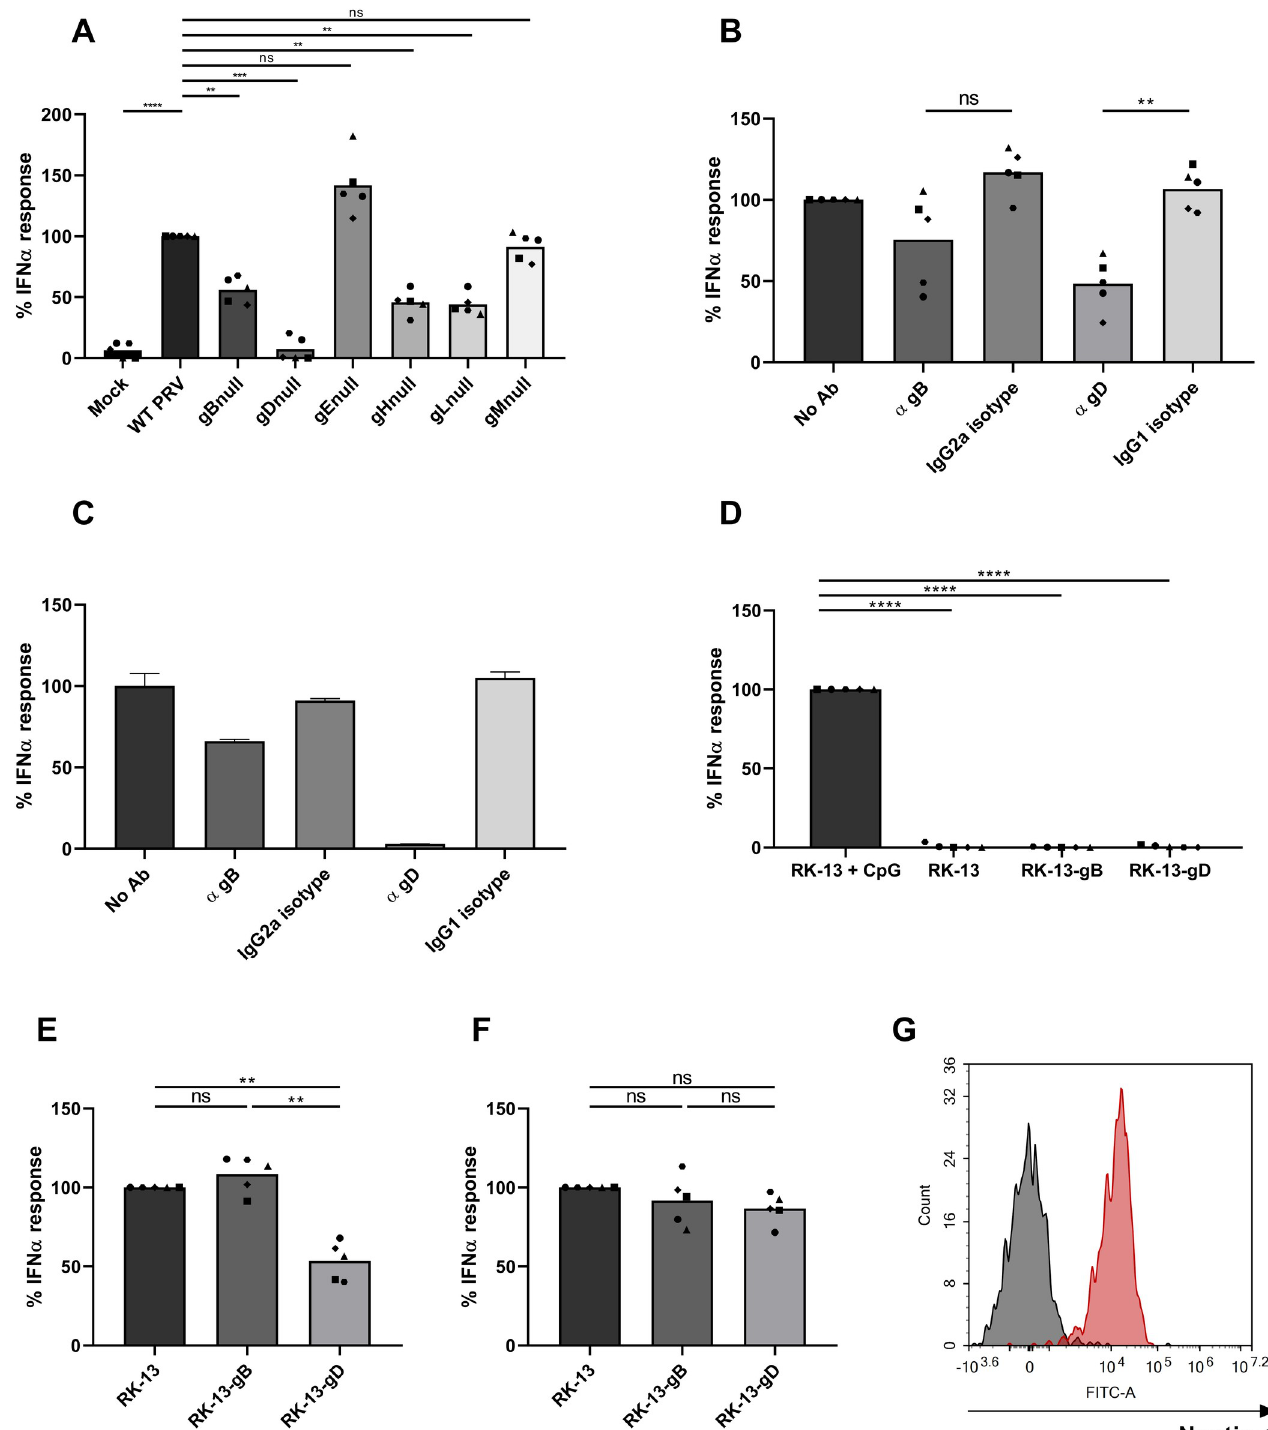
Fig 3. The PRV envelope glycoprotein gD is required for pDC activation. (A) Porcine PBMC were stimulated for 22h with supernatant from either mock- inoculated ST cells or ST cells infected with WT PRV Kaplan or isogenic single glycoprotein deletion mutants that was collected at 24hpi (and normalized based on viral genome levels). IFN α levels were determined by ELISA. IFN α responses are normalized to the WT PRV response (set to 100) for each of the five independent repeats. (‘ns’ not significant, ‘ �� ’ P < 0.01, ‘ ��� ’ P < 0.001, ‘ ���� ’ P < 0.0001). (B) PRV virions were incubated with or without different monoclonal antibodies (10 μ g/mL) for 1h at 37˚C and subsequently added to porcine PBMC for 22h. The measured IFN α responses are normalized to the condition